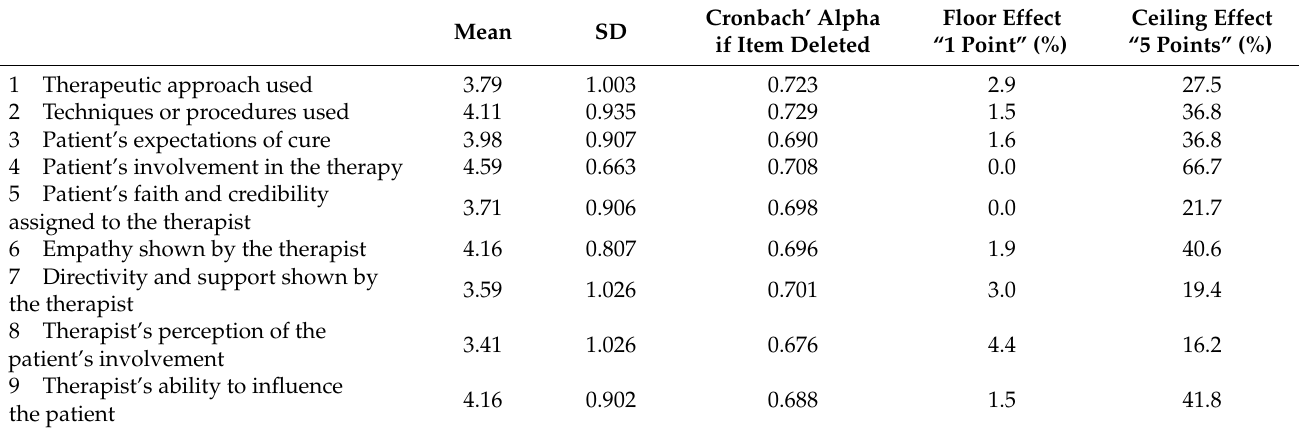
Table 3. Position of items with score means and standard deviations and reliability